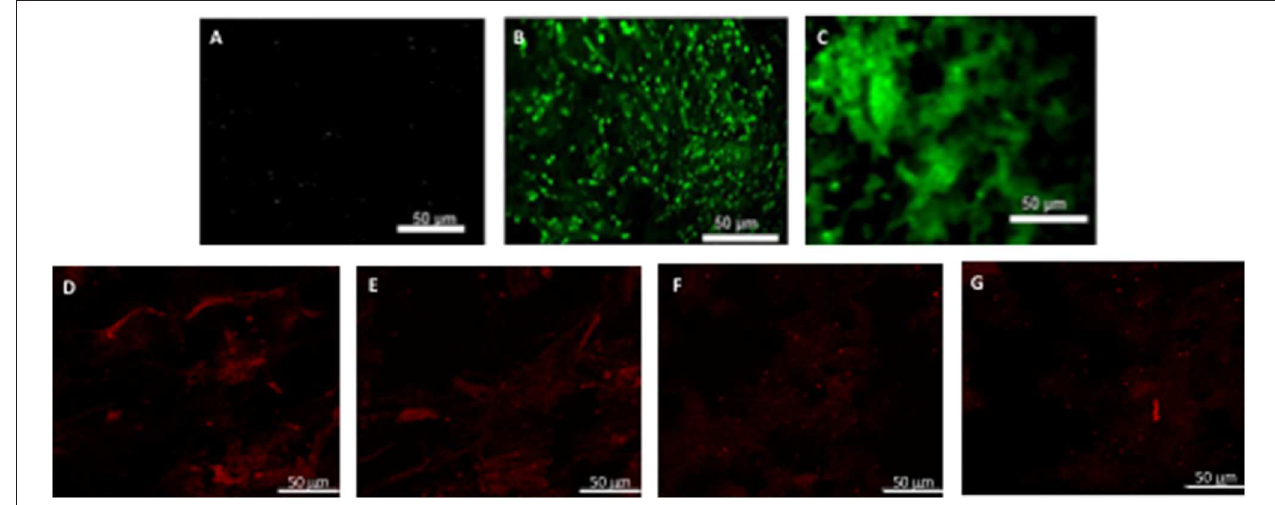
FIGURE 5 | hBM-MSCs differentiation toward α -SMA phenotype. PGA-PLLA scaffolds seeded with hBM-MSCs (5) demonstrated the presence of α -SMA phenotype in (A) static, (B) flex-flow and (C) PHV groups; the same cell-seeded scaffolds from our experiments focusing on (D,E) static, and (F,G) physiologically-relevant oscillatory flow groups demonstrate the presence of α -SMA phenotype. Image magnification of 72X.